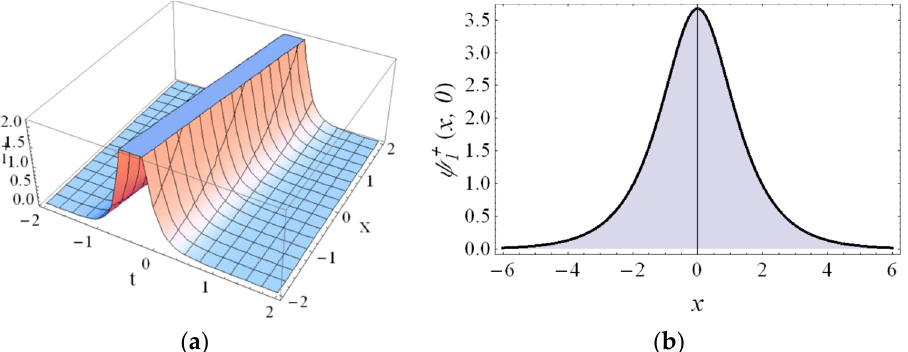
( ) + ψ = k = c tx , ( x , t ) with k = 1, c = 6. ( a ) 3-D plot, ( b ) 2-D curve for with 1 , 6 . ( a ) 3-D plot, ( b ) 2-D curve 1 1